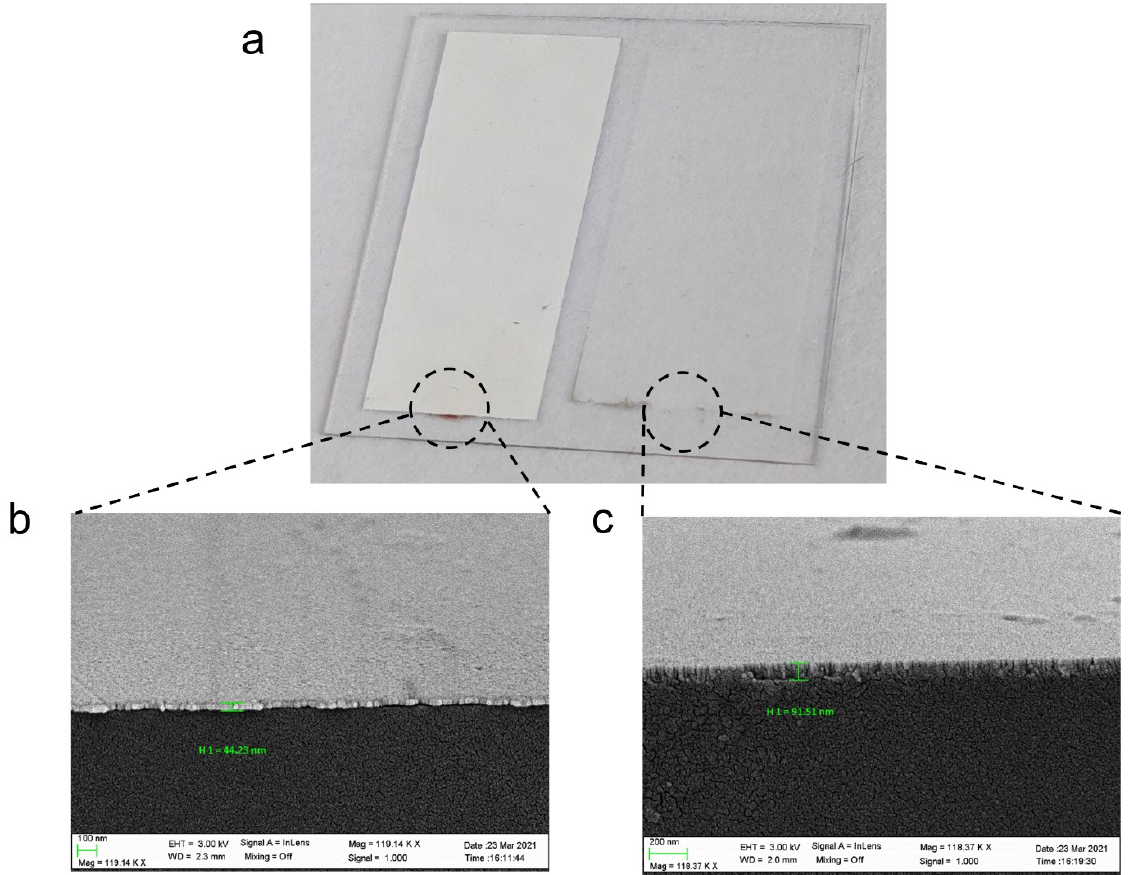
Figure 3. ( a ) Coverslip deposited with silver (left part) and ITO (right part). The separation between both thin films is 1 mm. ( b ) FESEM image of the cross section of the part of the coverslip deposited with silver. ( c ) FESEM image of the cross section of the part of the coverslip deposited with